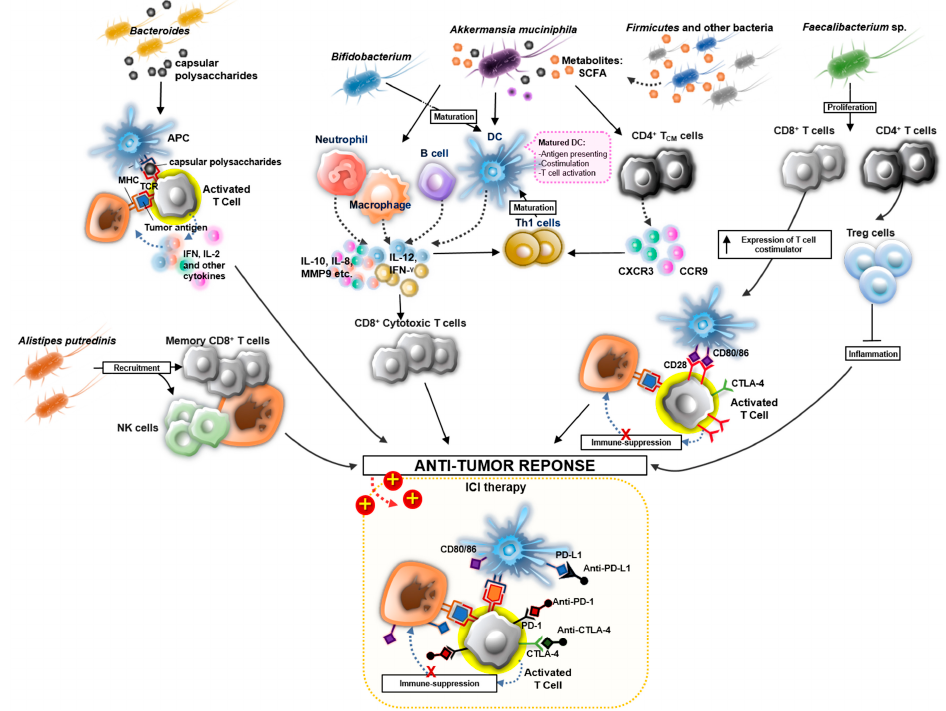
Figure 3. Microbiome related to the response to ICI. Several microbiomes were identified to improve the responses to ICIs directly by stimulating primary and adaptive immune responses to kill tumor cells and indirectly by inducing the release of SCFAs to activate immune responses. The microbiome induced the overexpression of T cell costimulatory, which activates T cells involved in